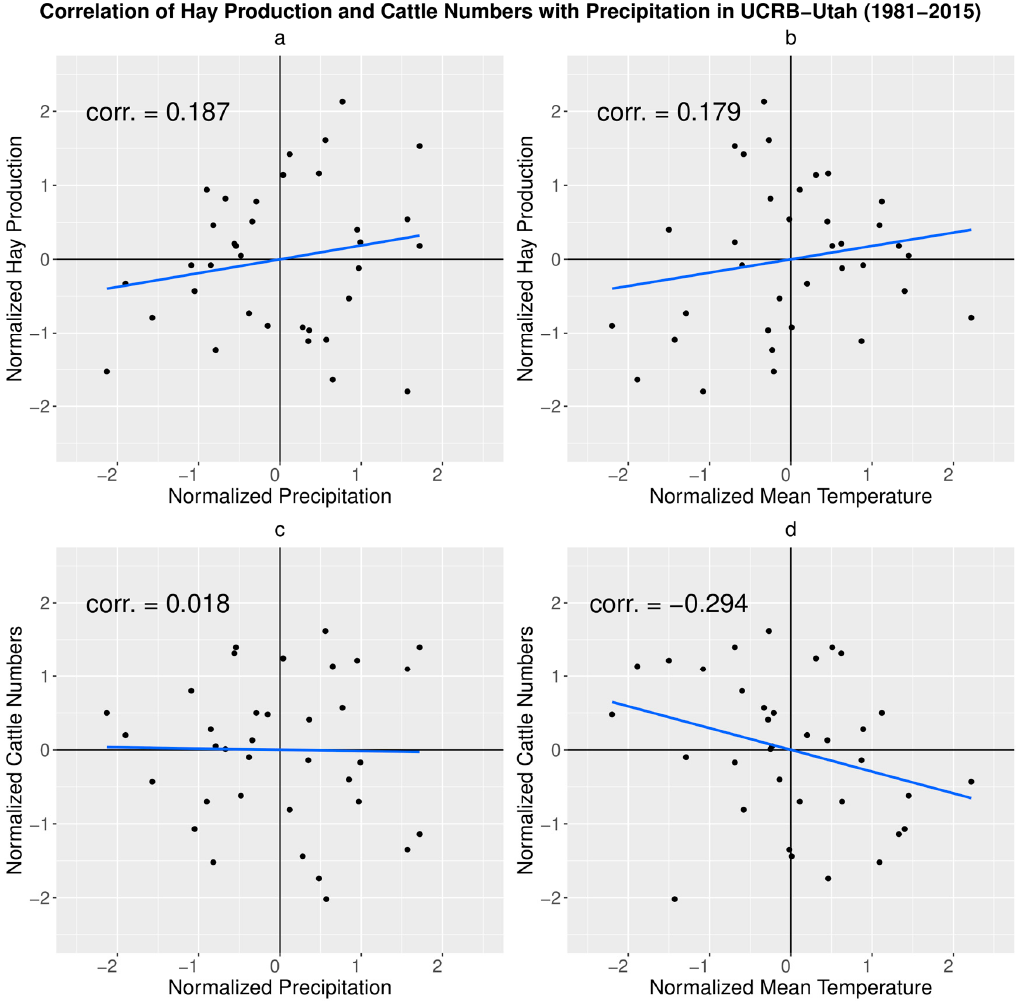
Figure 4. Correlation plots for precipitation and temperature with hay and cattle number with precipitation in UCRB-Utah, ( a ) hay production with precipitation, ( b ) hay production with mean temperature, ( c ) cattle numbers with precipitation, ( d ) cattle numbers with mean temperature.